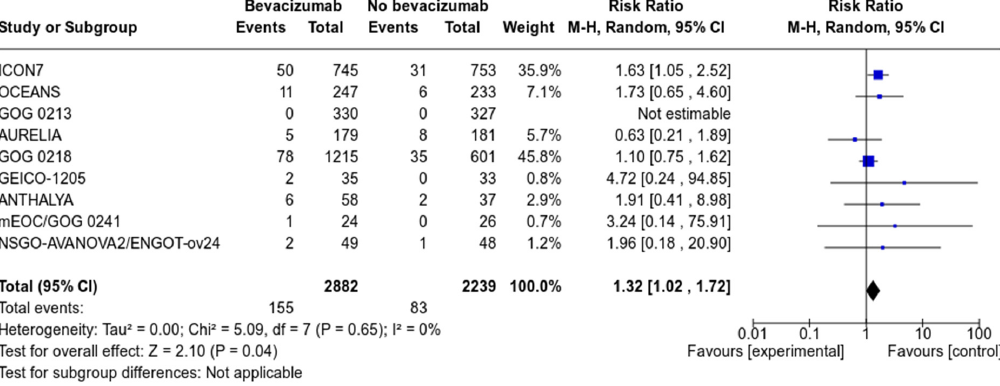
Figure 3. Forrest plot of venous thromboembolic events (VTE).